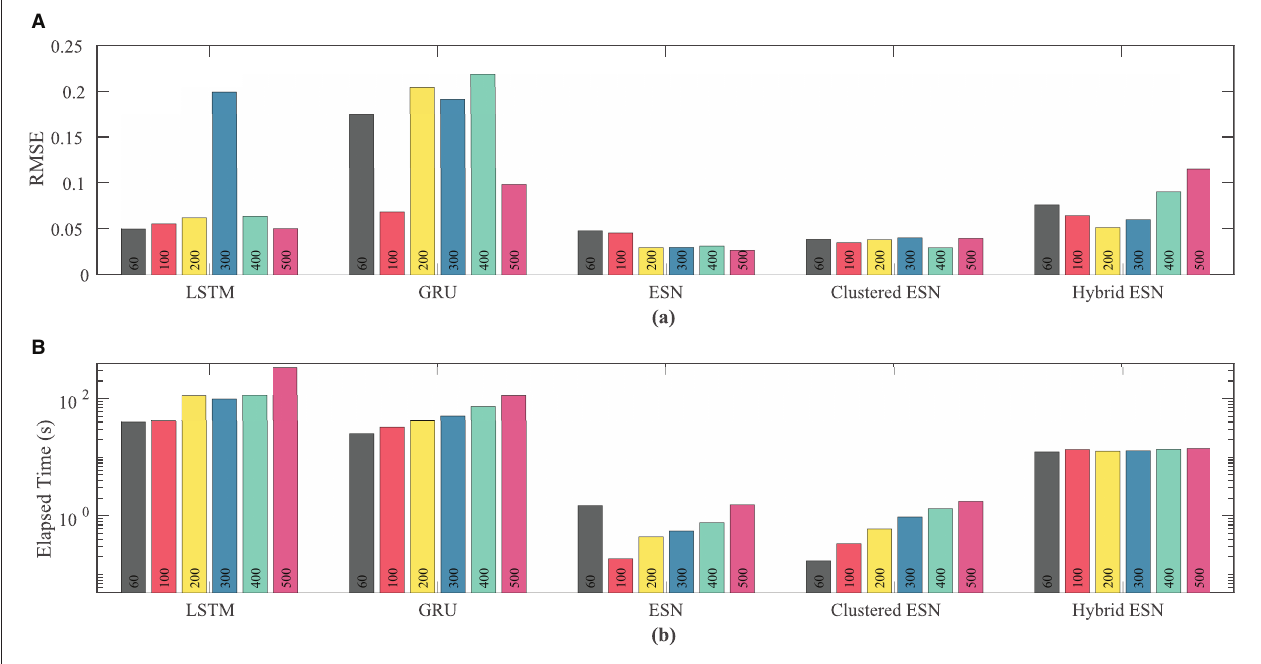
FIGURE 9 | Comparison of RMSE (A) and computational time (B) for each method and network size tested for the Noble